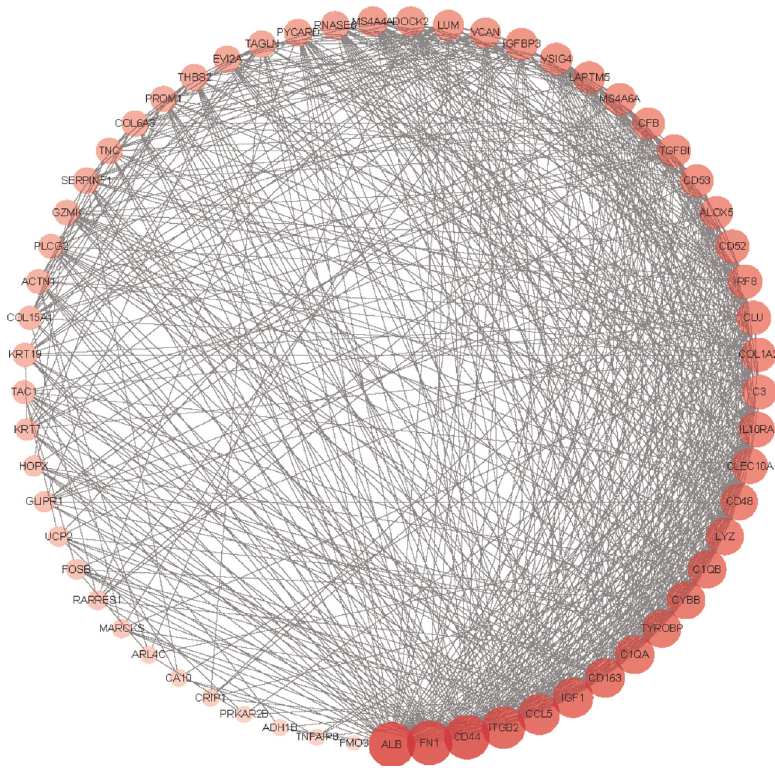
Figure 4: PPI network visualization and